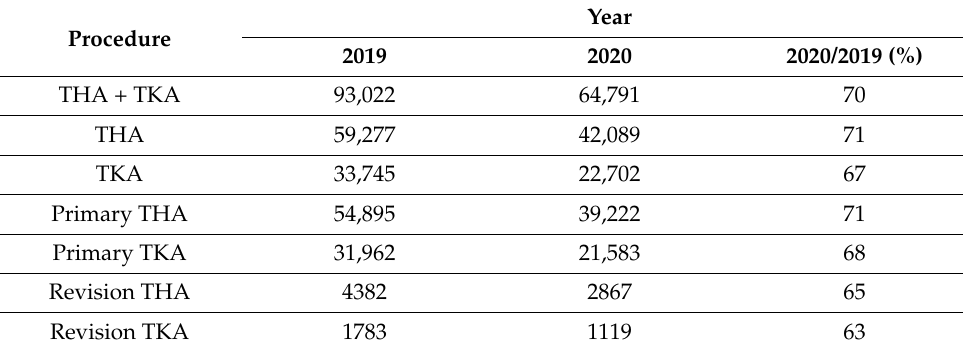
Table 1. Numbers of total hip arthroplasties (THA) and total knee arthroplasties (TKA) performed